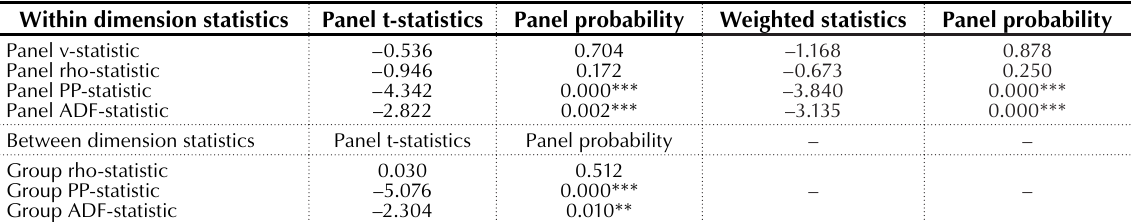
Tabel 3. Pedroni panel cointegration